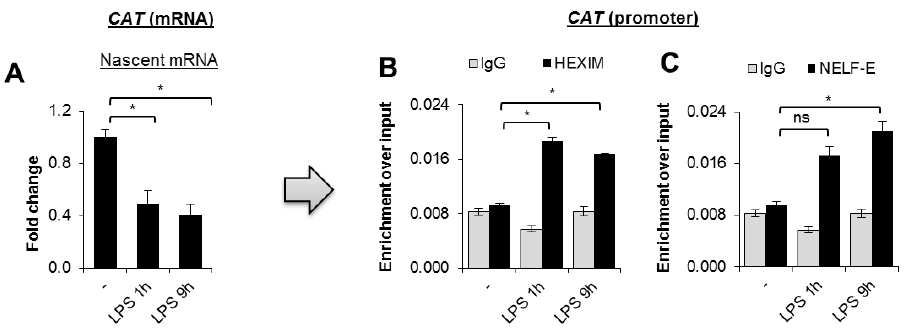
Figure 2. CAT repression is associated with the formation of POL2RA pausing complex in response to macrophage activation with LPS. ( A ) Newly minted RNA of CAT was captured by Click-iT chemistry after macrophage treatment with LPS for 1 and 9 h. ( B,C ) RNA polymerase II pausing in response to TLR4 stimulation was monitored by measuring HEXIM and NELF-E recruitment to the CAT promoter by ChIP-qPCR. Bars in the figures represent mean ± standard error of the mean (SEM). One-way analysis of variance (ANOVA) was carried out in GraphPad Prism 5 to compare means in several groups and the differences between each two groups were tested with the Tukey post hoc test (marked with * when p < 0.05 and with ns when p > 0.05).